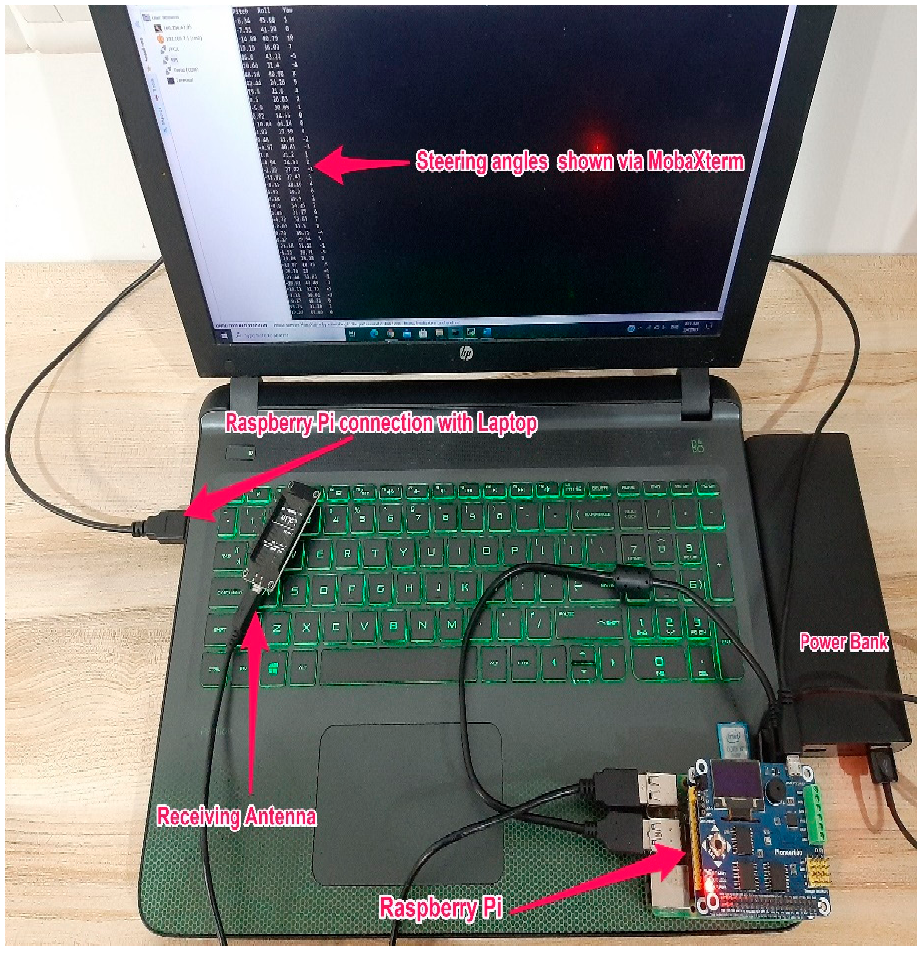
Figure 7. Receiving side of the IMU system.